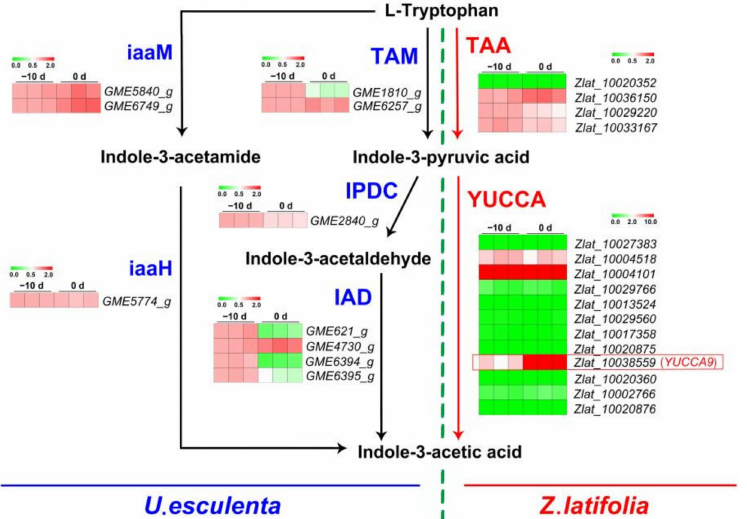
Figure 8. Validation of the RNA-Seq data of key enzymes in the IAA biosynthesis pathway using qRT-PCR at the initial stage of stem-gall formation. Black lines and blue letters denote the IAM pathway and IPyA pathway and the key enzyme in IAA synthesis in U. esculenta . Red lines and letters indicate the IAA synthesis pathway and key enzymes in the host plant Z. latifolia . The relative expression was determined by the 2 − ∆∆ CT method. MeV version 4.9.0 software (Dana-Farber Cancer Institute, Boston, MA, USA) was used for the statistical